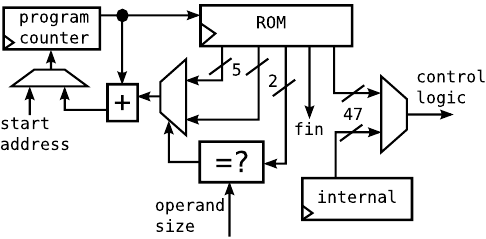
Figure 11: Optimized state machine to operate Carmela256